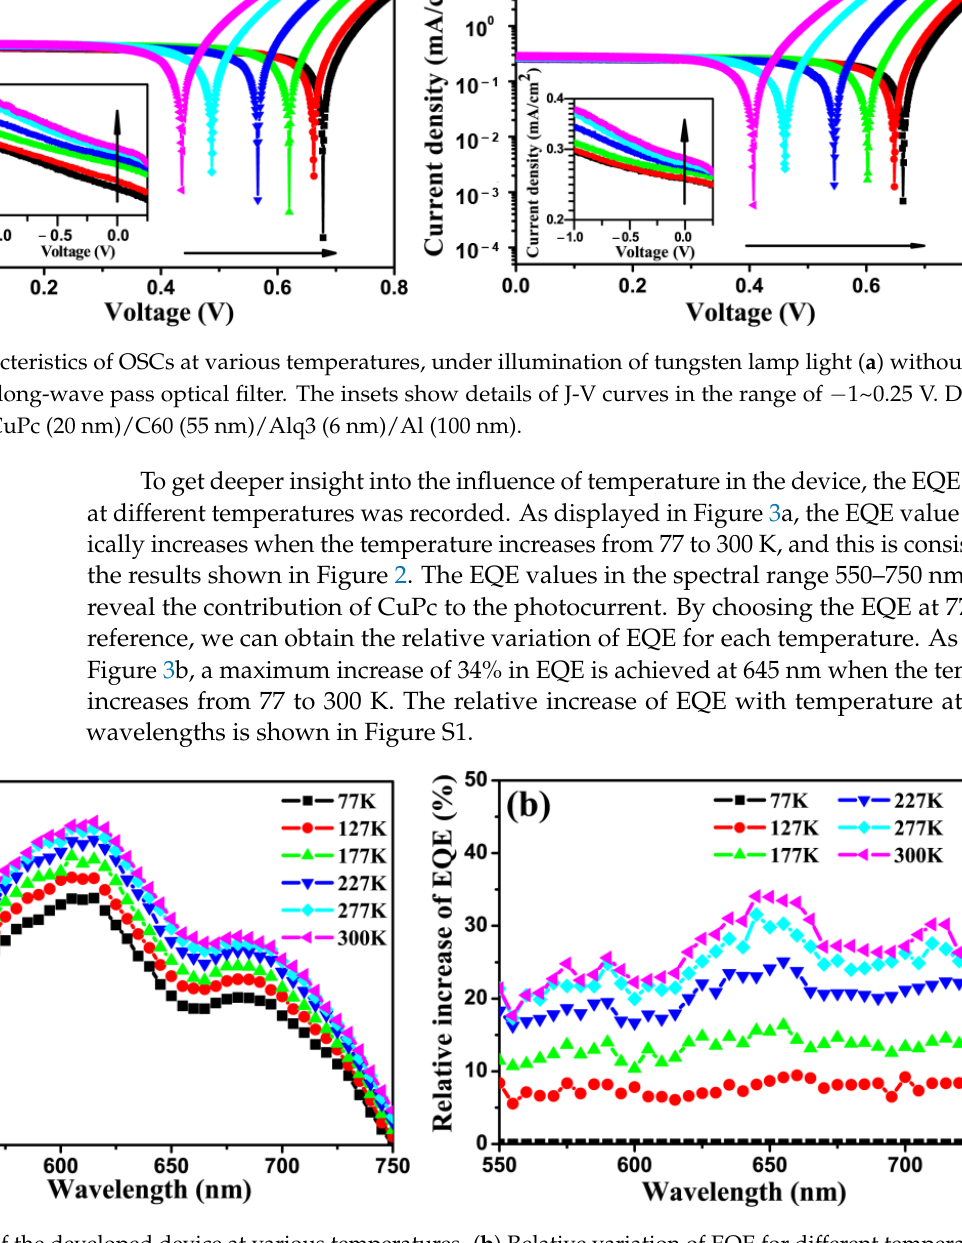
Figure 3. ( a ) EQE of the developed device at various temperatures. ( b ) Relative variation of EQE for different temperatures with the EQE at 77 K being chosen as reference.